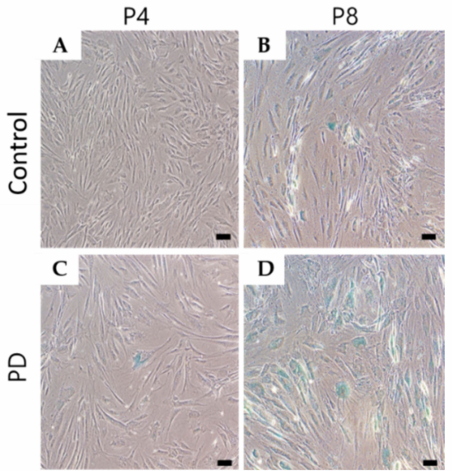
Figure 2. Comparison of cell senescence-associated β -galactosidase (SA- β -Gal) staining between control and Parkinson’s disease (PD) at passages 4 and 8 ( A – D ). SA- β -Gal activity in mesenchymal stem cells (MSCs) from a PD patient and healthy control. ( A ) MSCs from a control subject at passage 4. ( B ) MSCs from a control subject at passage 8. ( C ) MSCs from a patient with PD at passage 4. ( D ) MSCs from a patient with PD at passage 8. scale bars = 50 µ